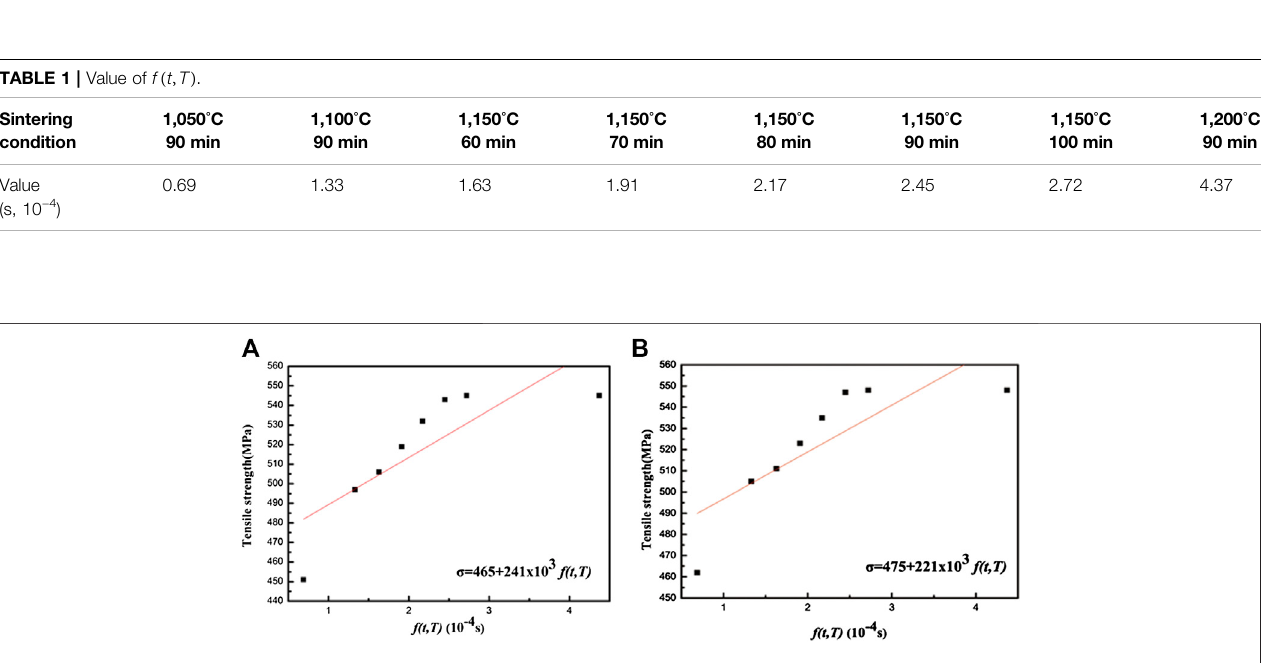
Frontiers in Materials |